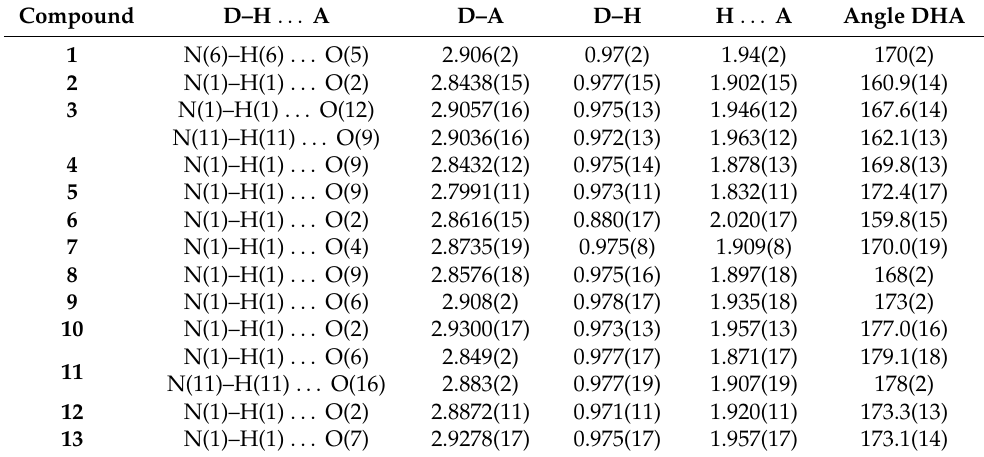
Figure 4. Structure of crystallographically characterised reference compounds 14–22 with CCDC Ref. Codes and literature references.